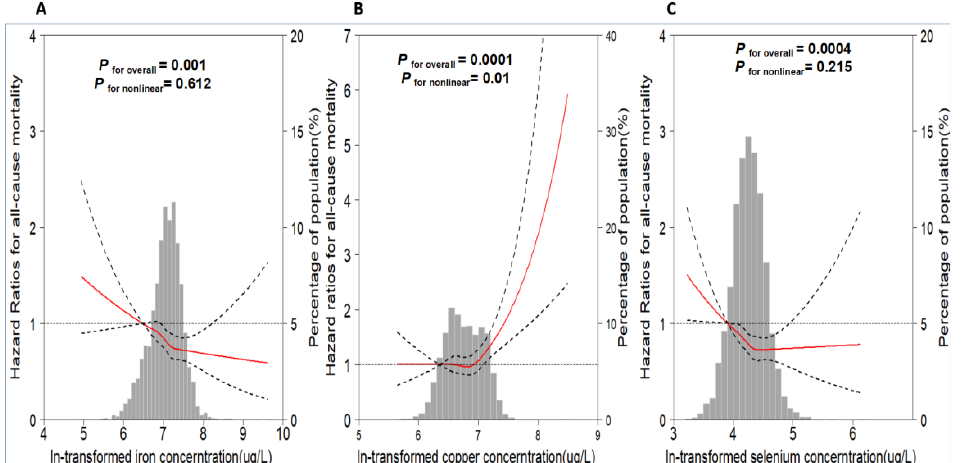
Figure 1. The restricted cubic spline for the association between plasma metals (( A ): iron; ( B ): copper; ( C ): selenium) and all-cause mortality among type 2 diabetes individuals. Knots were placed at the 20th, 40th, 60th and 80th percentile of the distribution of plasma metal concentration, with the reference value were set at the 10th percentile. The black line was hazard ratio; dashed lines were 95% confidence intervals. Adjustment factors were age, gender, BMI, education, smoking status, drinking status, physical activity status, baseline FBG, duration of diabetes, and use of antidiabetics and eGFR at baseline.